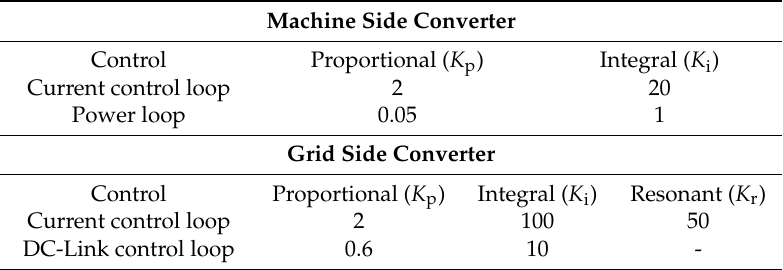
Table A1. Controller’s